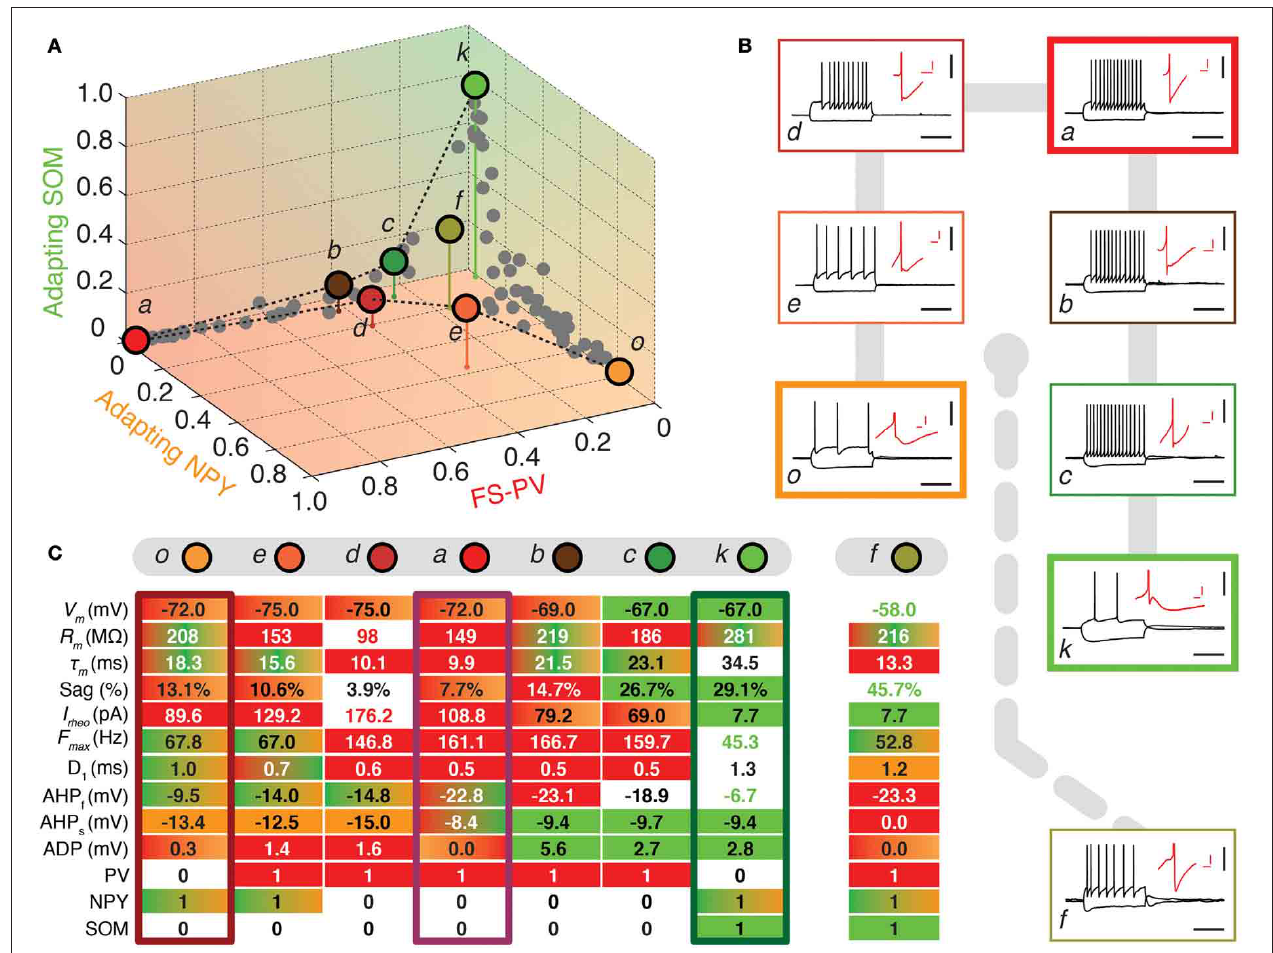
FIGURE 3 | Walking outward from the FS-PV archetype. (A) Tetrahedral representation linking FS-PV (red), Adapting NPY (orange), and Adapting SOM archetypes (green). Individual neurons are depicted as dots in the 3D space of memberships. The X, Y, and Z axes correspond to memberships to the FS-PV, Adapting NPY, and Adapting SOM archetypes, respectively. Vertical stems denoting the projection of selected cells on the bidimensional base plane are introduced as depth clues. (B) Current-clamp recordings of illustrative transition neurons (cells a to o colored in panel A ) in response to rheobase current and to a 100pA hyperpolarizing current pulse (black traces, scale bars 50mV, 400ms). Insets: details of the repolarization phase of the